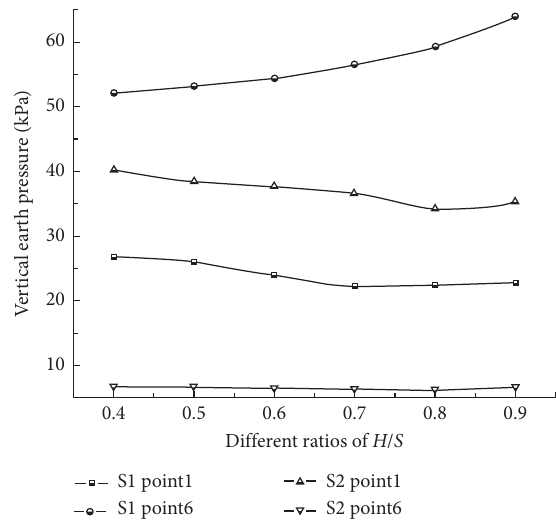
Figure 6: Vertical earth pressure of different H/S ratios at points 1 and 6 for cases S1 and